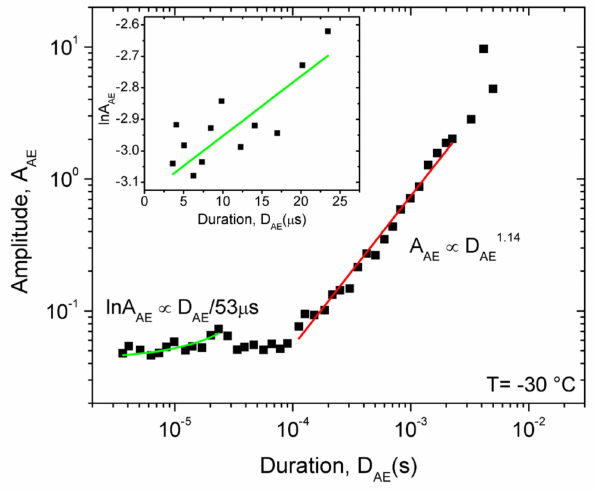
Figure 9. Relation between A AE and D AE at − 30 ◦ C. The straight red line fitted at large values of D AE = 1.14, i.e., γ = 1.88 (see Table 3 as well). From has the slope (in accordance with Equation (3)) 1 γ − 1 the green curves fitted at short durations (see the insert as well, which show the ln A AE versus D AE function) τ a = 50 µ s was